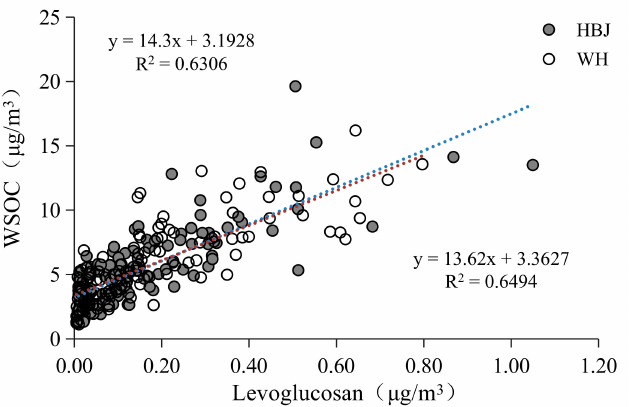
Figure 2. Correlation between levoglucosan and WSOC at the HBJ and WH